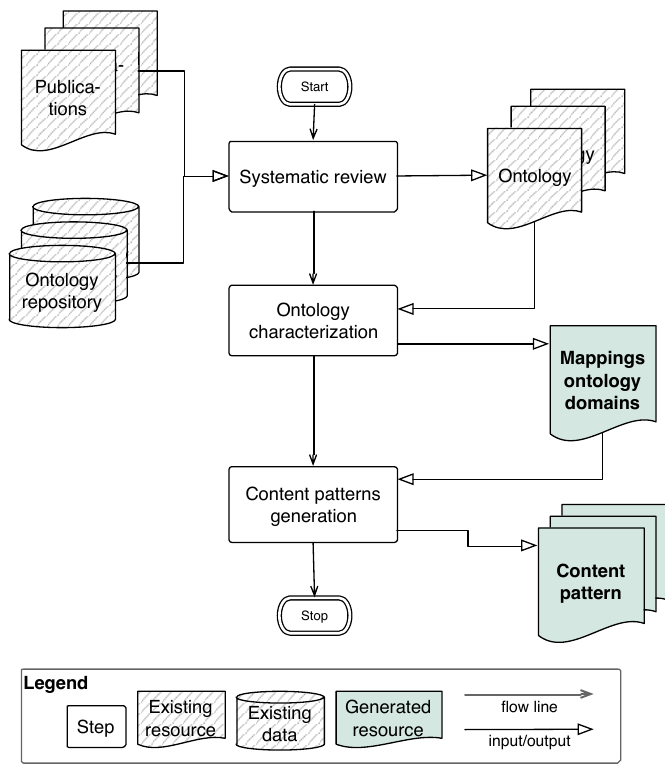
Figure 1. Three-step methodology to identify ontology design patterns in smart cities’ ontologies.